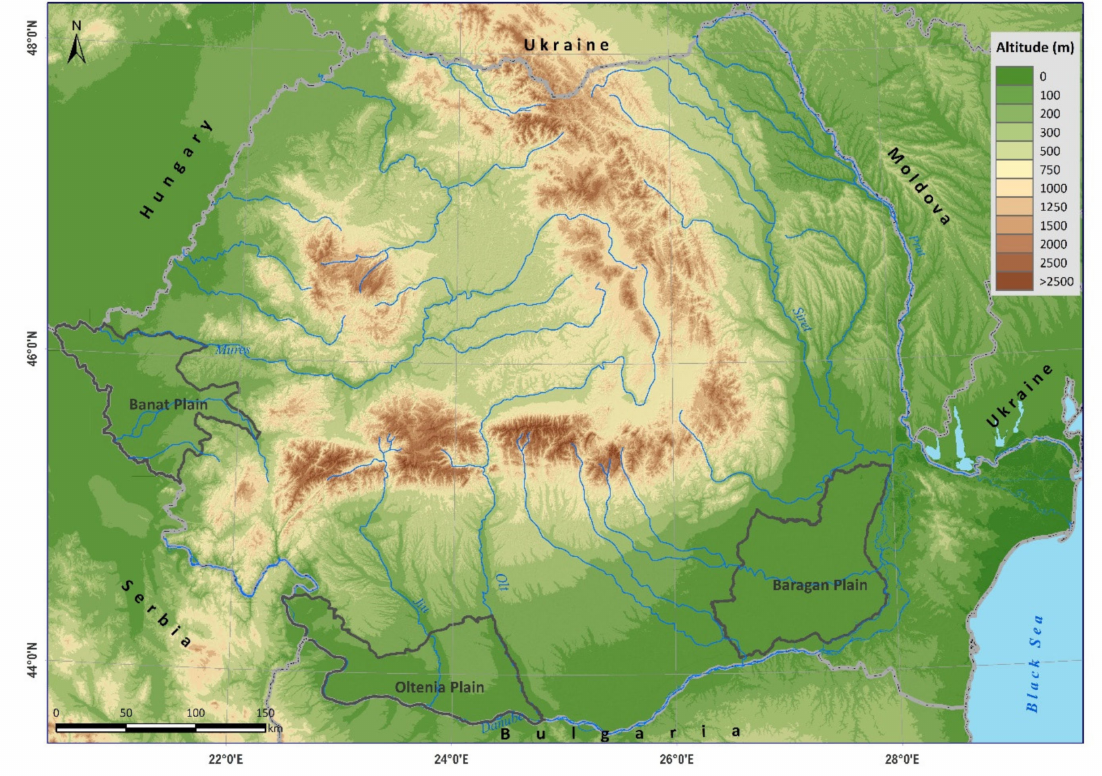
Figure 1. Location of study areas (dark gray polygons on the map) within